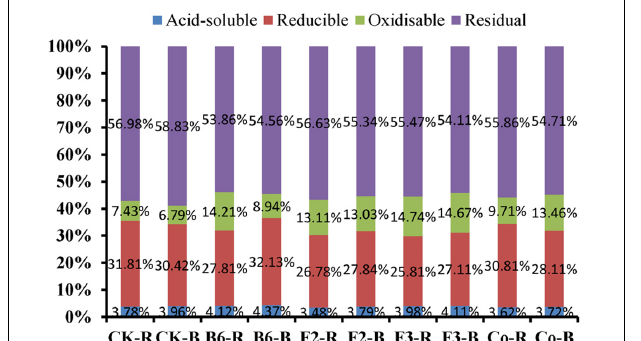
FIGURE 4 | Effects of microbial inoculation on heavy metal speciation in the rhizosphere and bulk soil. CK-R, rhizosphere soil in CK; CK-B, bulk soil in CK; B6-R, rhizosphere soil in inoculation with Bacillus sp.; B6-B, bulk soil in inoculation with Bacillus sp.; F2-R, rhizosphere soil in inoculation with Clonostachys rosea ; F2-B, bulk soil in inoculation with Clonostachys rosea ; F3-R, rhizosphere soil in inoculation with Aspergillus niger ; F3-B, bulk soil in inoculation with Aspergillus niger ; Co-R, rhizosphere soil in inoculation with Bacillus sp. and Aspergillus niger ; Co-B, bulk soil in inoculation with Bacillus sp. and Aspergillus niger